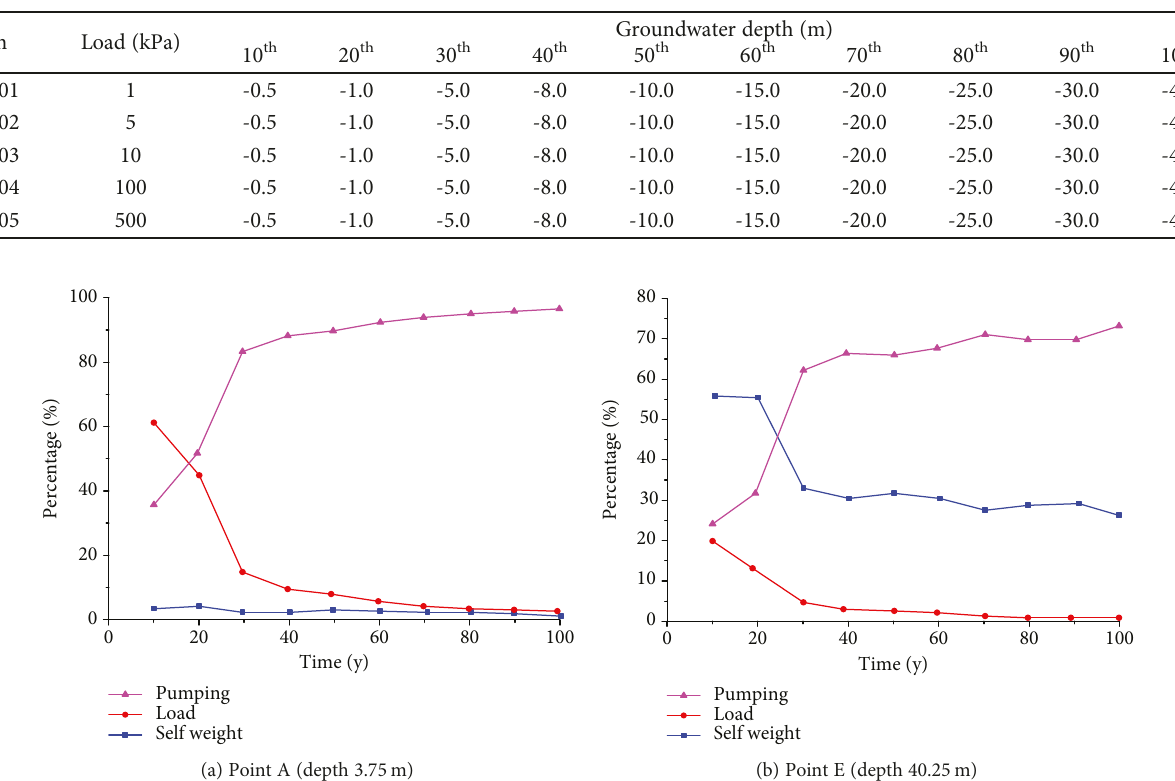
Figure 17: Percentage of settlement caused by di ff erent reasons when loading intensity is 1